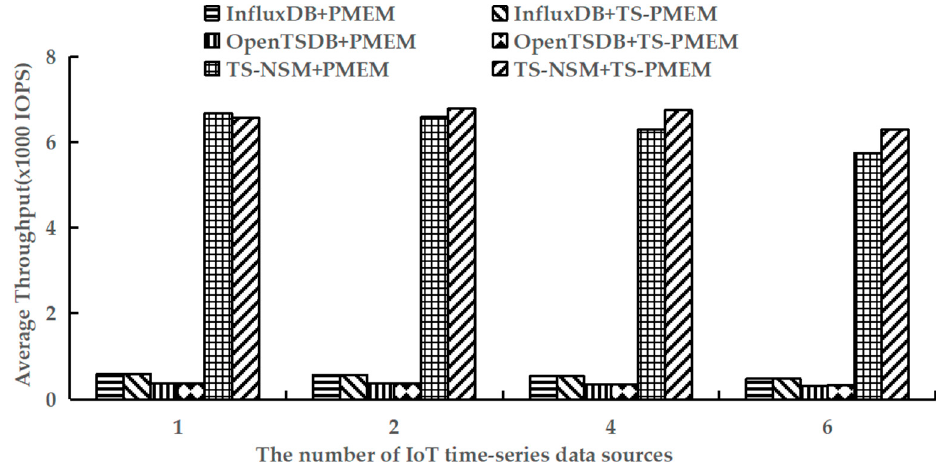
Figure 8. Average random query throughput under testworkloada.